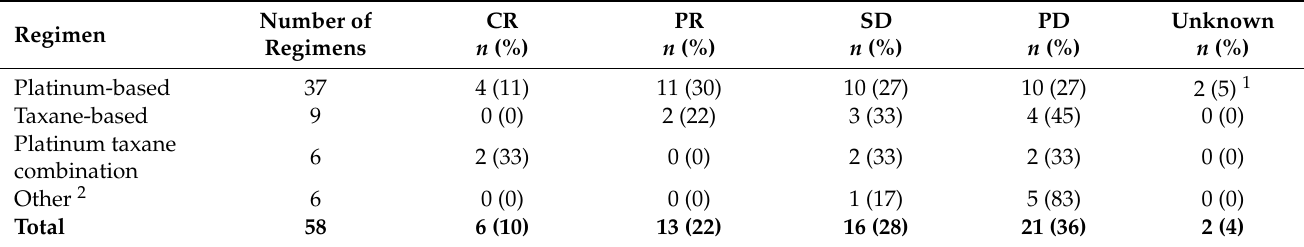
Table 3. Summary of response rates of chemotherapy for aGCT.